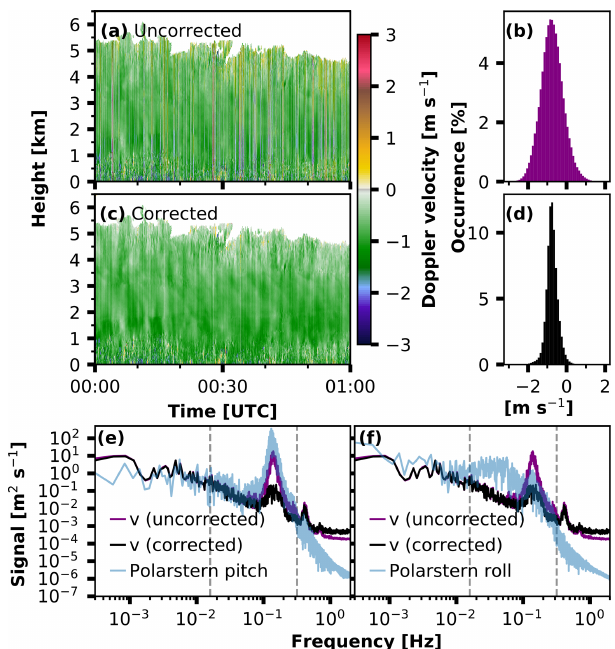
Figure 6. (a) Uncorrected and (c) corrected Doppler velocity dur- ing PASCAL on 30 May 2017 between 00:00 and 01:00UTC. Pan- els (b) and (d) represent the respective histogram of the presented Doppler velocity. Negative values denote downward motion. In pan- els (e) and (f) , the mean Fourier spectrum of the uppermost, contin- uous time series of the (uncorrected) Doppler velocity during the same period in black (purple) is shown. In panel (e) , in addition, the spectrum of the Polarstern pitch movement during this period is de- picted. In panel (f) the respective spectrum of the roll movement is shown. The dashed lines in panels (e) and (f) indicate the frequency range which was used to quantify the effect of the heave